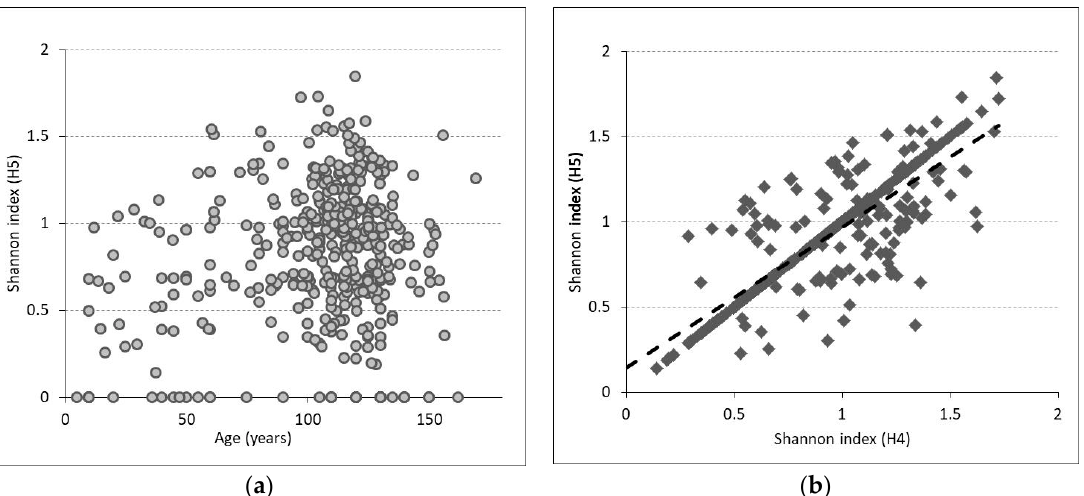
Figure 6. ( a ) Variation in the Shannon index (H5) in relation to stand age, and ( b ) Shannon diversity calculated at the level of the mean diameter and height of the stands.